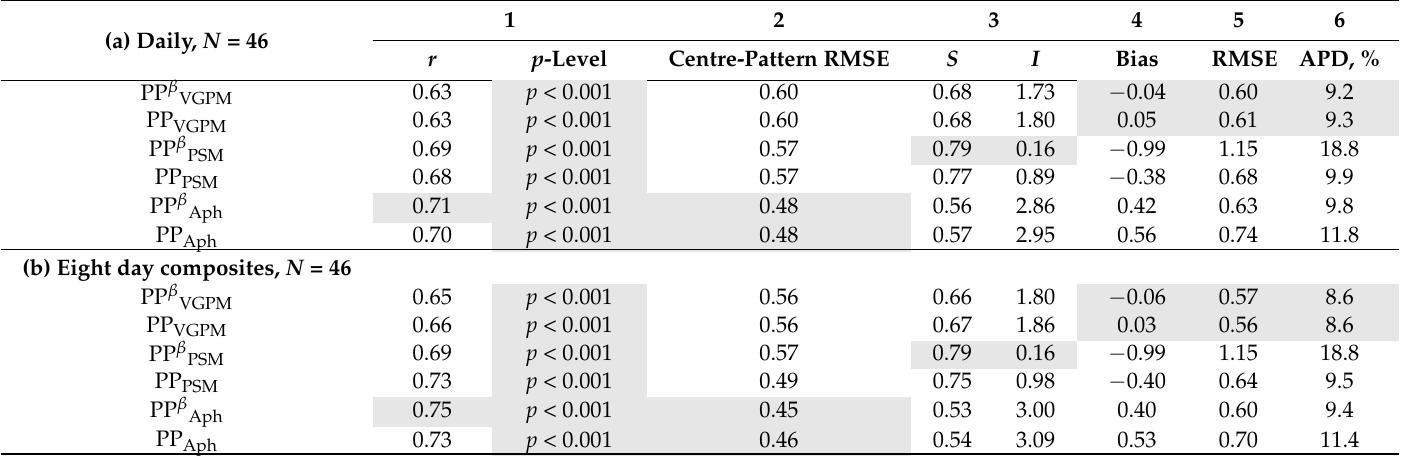
Table A2. Validation statistics for each model using (a) daily and (b) eight day composite OC-CCI data ( N = 46). The numbers at the head of the table indicate statistics for one test. The most significant statistical values are highlighted in grey. r is the Pearson pair correlation coefficient, S is the Slope and I is the Intercept of the linear regression coefficients, RMSE is the Root Mean Square Error, and APD is the Absolute Percentage